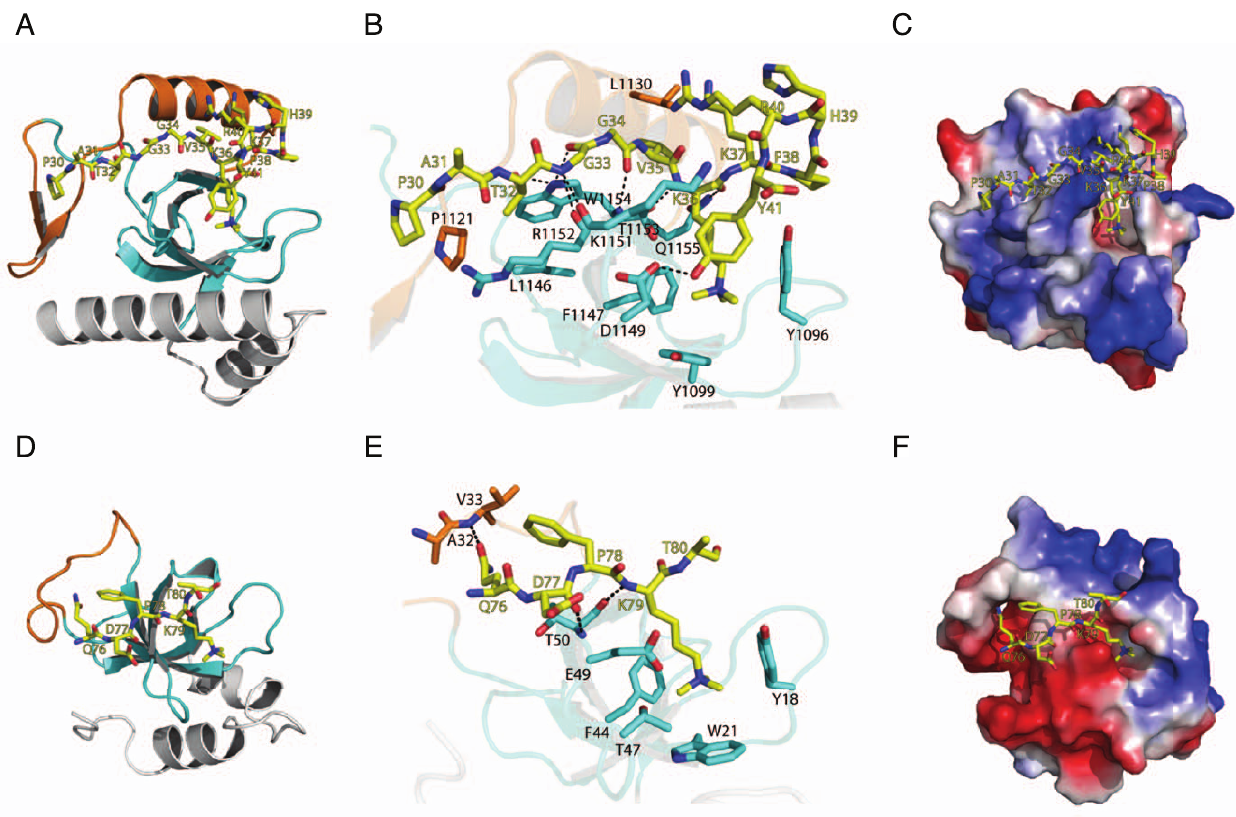
Figure 4. Complex structures of BRPF1-H3K36me3 and HDGF2-H3K79me3. (A) Structure of BRPF1 PWWP domain in complex H3K36me3 peptide. The PWWP domain is shown in cartoon, and the peptide is shown in a stick model. (B) The detailed interactions between the BRPF1 PWWP domain and H3K36me3. Hydrogen bonds are shown in dashed lines. (C) Electrostatic surface representation of BRPF1-H3K36me3 complex. (D) Structure of HDGF2 PWWP domain in complex H3K79me3 peptide. The PWWP domain is shown in cartoon, and the peptide is shown in a stick model. (E) The detailed interactions between the HDGF2 PWWP domain and H3K79me3. Hydrogen bonds are shown in dashed lines. (F) Electrostatic surface representation of HDGF2-H3K79me3 complex.